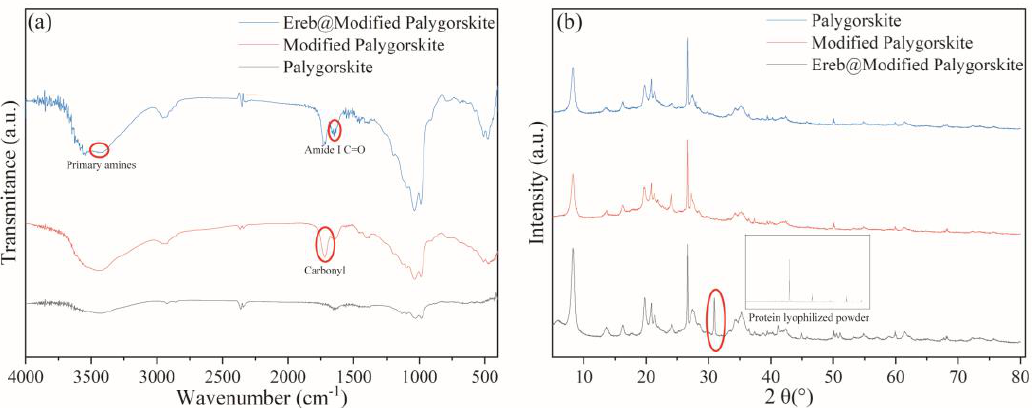
Figure 4. ( a ) Fourier-transform-infrared spectra of palygorskite (black), modified palygorskite (red), and EreB@modified palygorskite (blue). ( b ) X-ray-diffraction patterns of palygorskite (black), modified palygorskite (red), EreB@modified palygorskite (blue), and crude protein lyophilized powder.